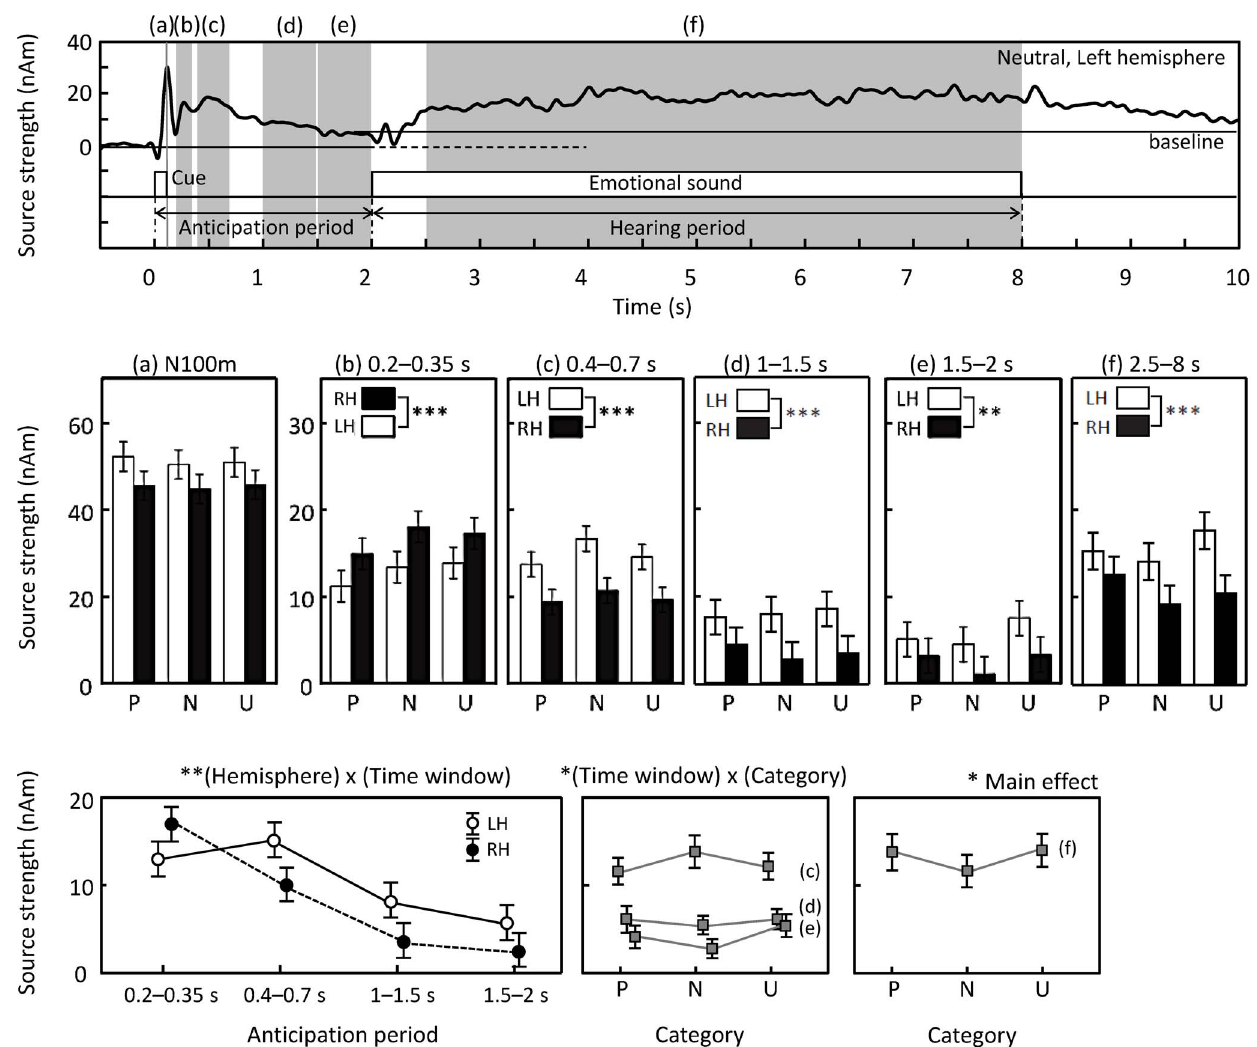
Figure 5. Results of statistical analysis. (top) Low-pass-filtered (at 8 Hz) response of the left hemisphere to neutral sounds (a trace from the middle left panel of Fig. 4). Shadowed belts (a)–(f) indicate time windows used for statistical analysis. (middle) Source strengths separately for the right (RH) and left (LH) hemispheres and sound categories within each time window (a)–(e). Baselines was from 2 0.5 to 0 s for the analysis of responses during the anticipation period (a)–(e), while it was from 1.8 to 2 s for the analysis of responses occurring during the hearing period (f). Mean 6 95% confidence intervals are shown across all 15 participants. (bottom) Left panel shows the interaction effect for hemisphere and time window , centre panel shows the interaction effect for time window and category in late anticipation period (c)–(e), and right panel shows the difference between categories during actual hearing (f). Mean 6 SE (standard error) values are shown. * denotes p , 0.05, ** p , 0.01, *** p , 0.001 in the figures. (Figure 5, period f), with no main effect of category. Comparison of the hemispheric differences of responses to pleasant and unpleas- ant sounds revealed a tendency towards hemispheric interaction [F(1,14) =4.02, p = 0.067], suggesting that, despite a general left- hemisphere predominance of the signals, left-auditory-cortex responses tended to be stronger to unpleasant than pleasant sounds, whereas the situation was the opposite in the right auditory cortex (Figure 5(f); see also Figure 4, DC-coupled traces). When the data from both hemispheres were combined (averaging the individual dipole moments from both hemispheres), category also had a main effect in one-way ANOVA [ category (3); F(2,28)= 7.28, p = 0.003]. Post-hoc paired t-tests (with Bonferroni correction) showed that pleasant ( p = 0.048) and unpleasant ( p = 0.006) sounds both evoked stronger activity than did neutral